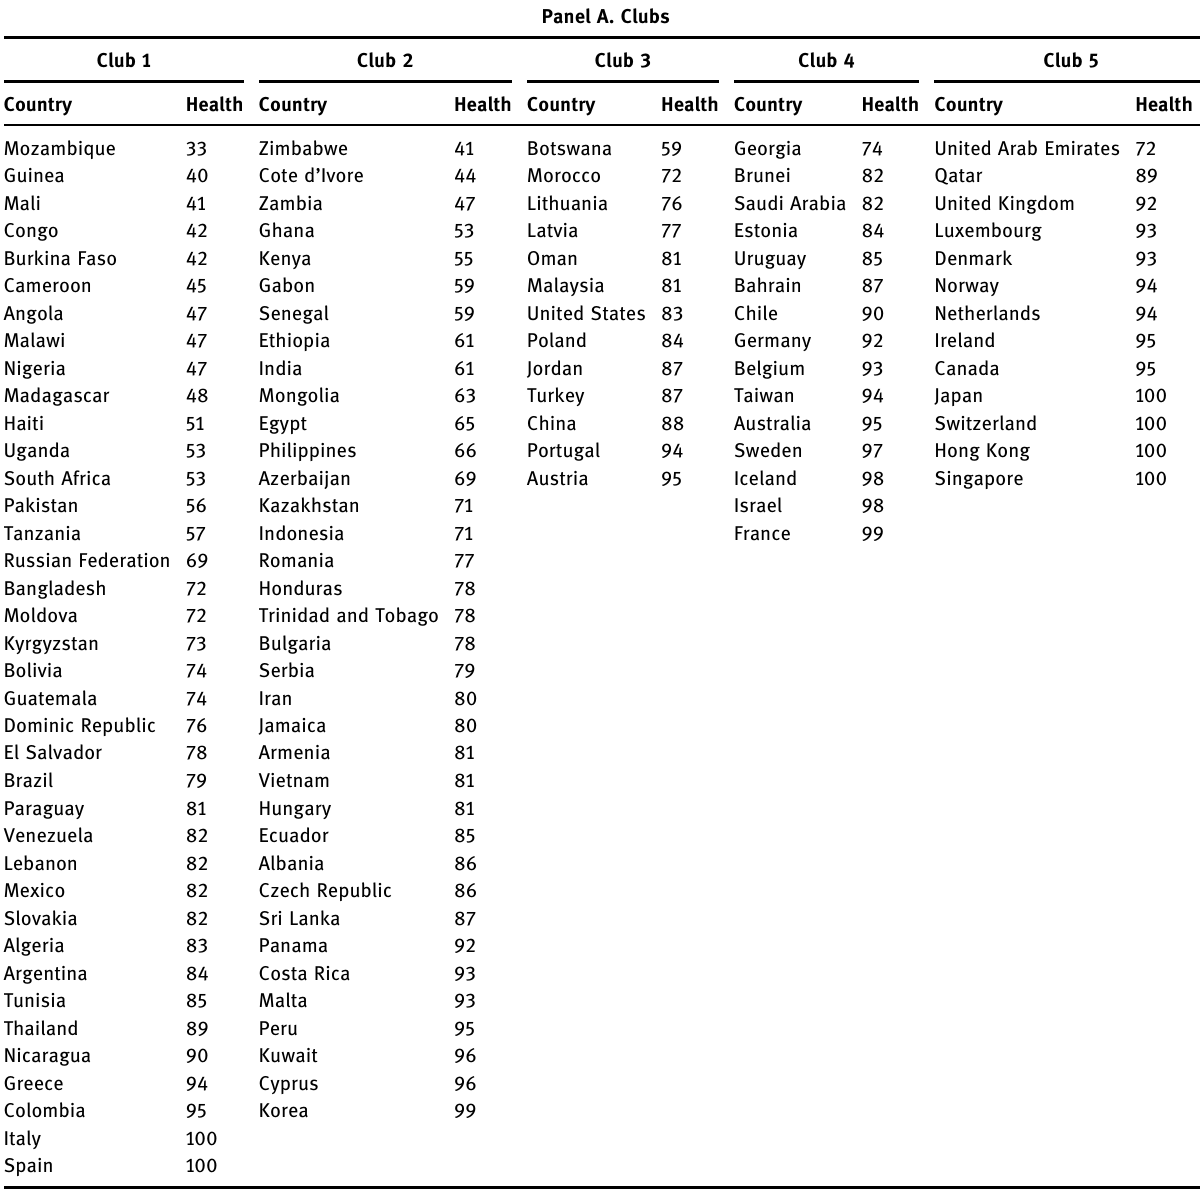
Table 8: Country scores. Health pillar